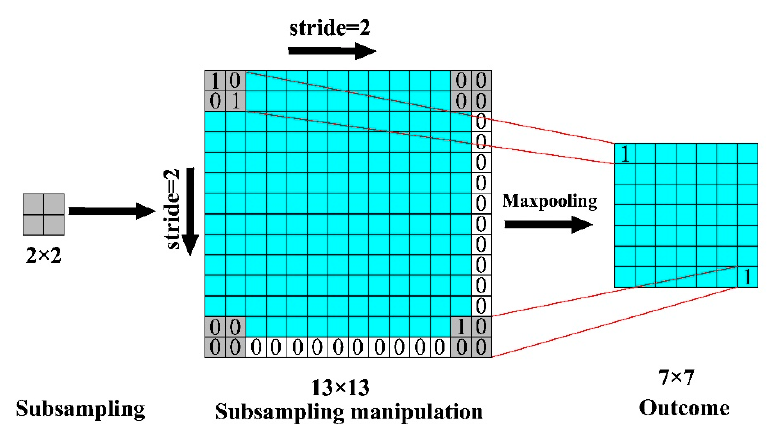
Figure 11. The convolution manipulation (SAME padding).